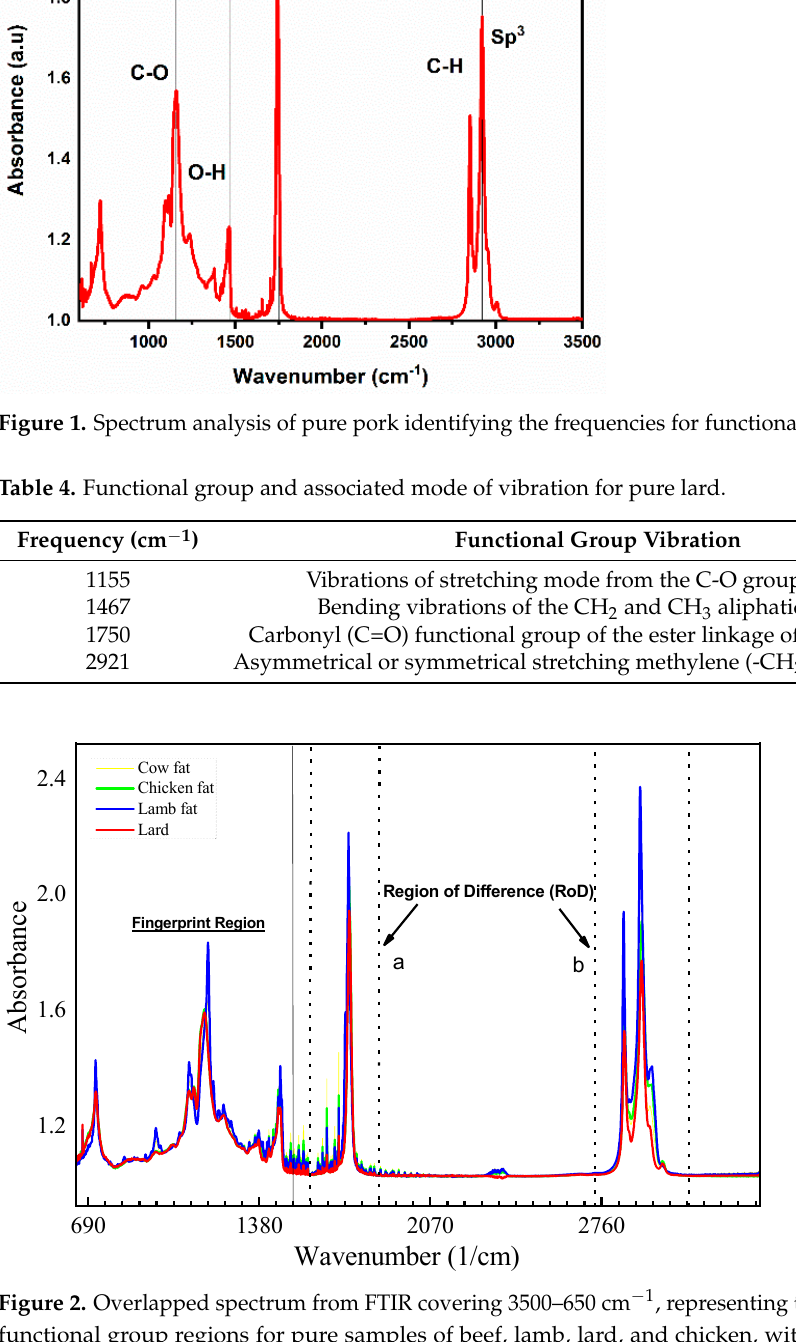
Figure 3. RoD(a) Region of difference peaks zoomed in at wavenumber 1700–1800 cm − 1 showing the absorbance value for pure samples denoted by a; lard has the lowest value among all samples. RoD(b) Zoomed-in peaks at wavenumber 2800–3000 cm − 1 where peaks denoted as a, b, and c rep- resent potential regions with difference in absorbance values for all samples. As the value for the adulteration of lard increases for both beef and chicken, the ab- sorbance values merge with the lard, showing high contrast compared to lamb samples, which indicates negligible change when lard is mixed. This is clearly visible in the spectral analysis shown in Figure 4 for all the adulterated samples. The absorbance values in the region of RoD(b) are carefully analyzed, where the adulteration of lard can potentially be detected. This is shown in Table 5. On the other hand, beef samples are highly prone, and lard is detectable because of the significant change in absorbance value at the region of 2800–3000 cm − 1 in the spectrum, specifically at RoD(b) a and b, which represent regions at 2840–2860 and 2900–2940 cm − 1 , respectively. Table 5 lists all the absorbance values at the peaks of RoD(b) in Figure 2; the percentage difference is calculated with respect to lard for peak absorbance in regions with high significance. Table 5. Absorbance values and percentage difference with respect to lard for adulterated samples of beef, lamb, and chicken in the region of RoD(b) at the highly significant region of 2800–3000 cm − 1 . Species Type